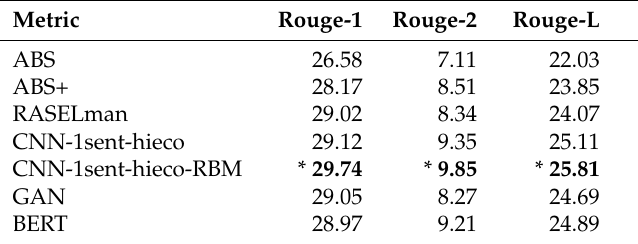
Table 2. The experimental results on DUC Corpus. * indicates the statistical significant